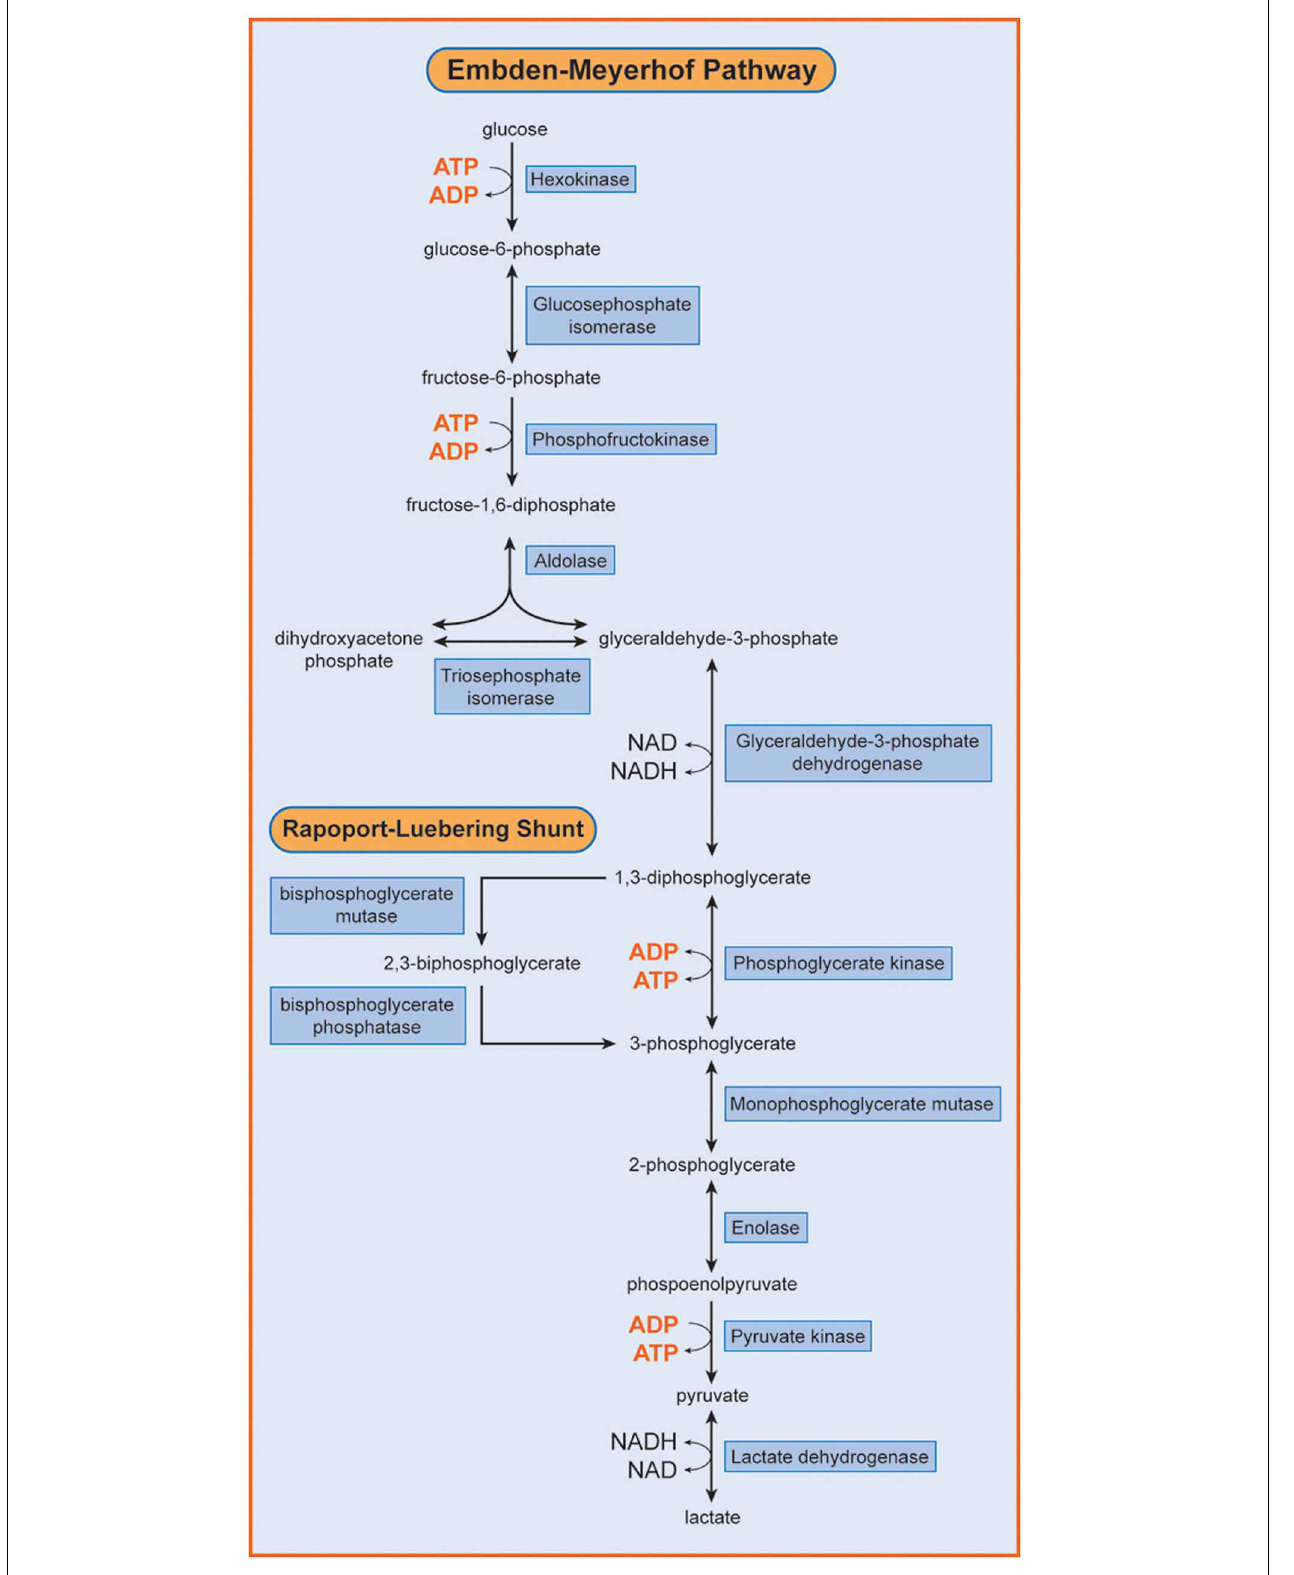
FIGURE 1 | Embden Meyerhof Pathway of RBC metabolism. Phosphofructokinase (PFK) catalyzes the transformation of fructose 6-phosphate into fructose 1,6 diphosphate. [Reproduced with permission from Van Wijk and van Solinge (2005)]